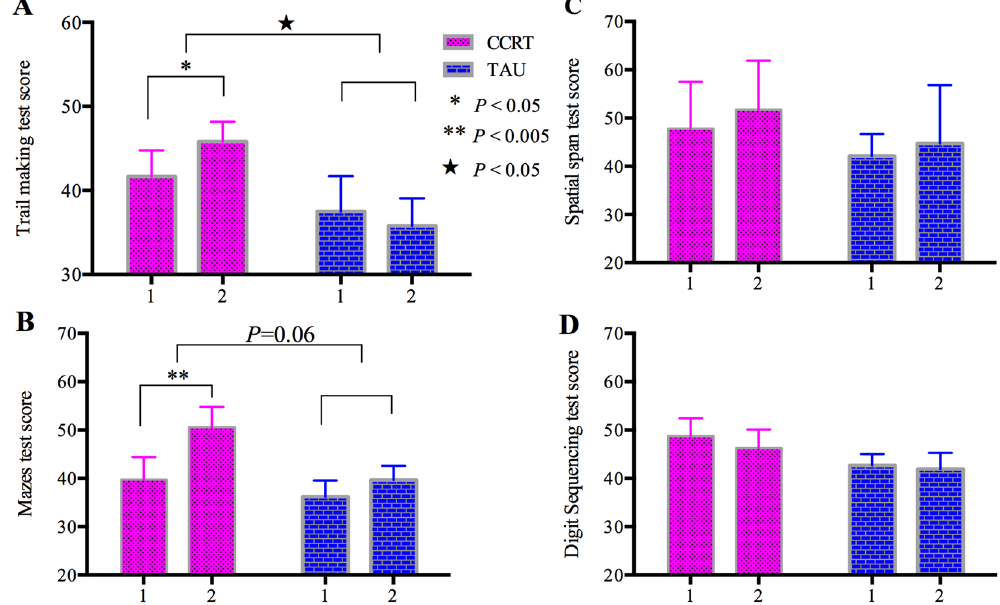
Figure 2. Comparison of cognitive function at baseline and post-treatment in computerized cognitive remediation therapy (CCRT) and treatment as usual (TAU) groups, including trail making test, mazes test, spatial span test and digit sequencing test. Note: in x axis, 1 = baseline, 2 = post-treatment. Scores in y axis represent T-scores of cognitive performance. ★ Means significant group × time interaction, * means significant treatment effect within group.